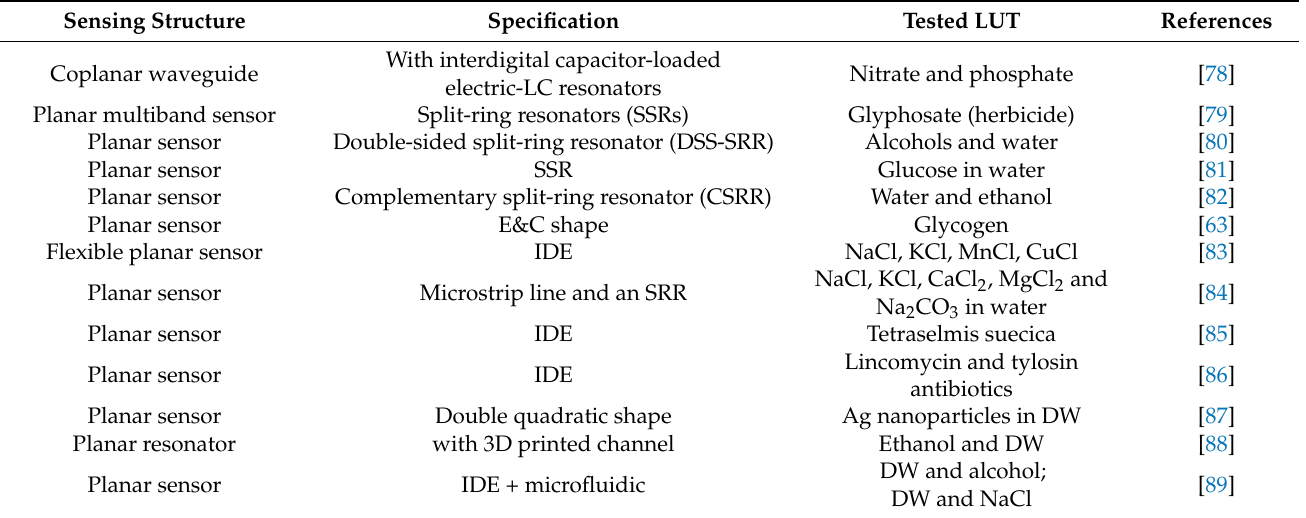
Table 3. Examples of planar structures and their tested application for liquid